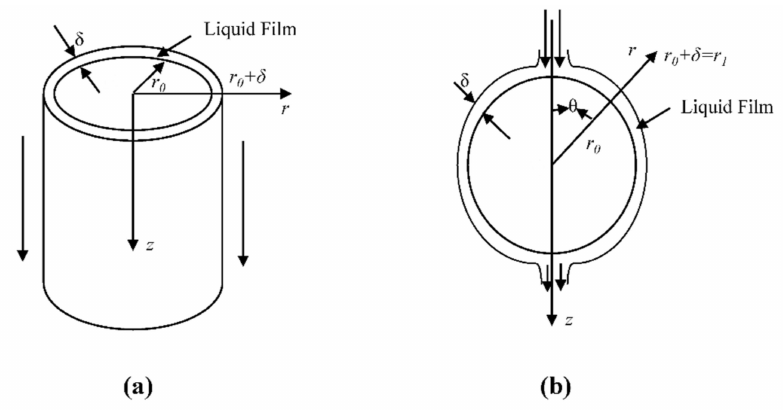
Figure 3. Microscopic magnification structure of copper foam metal.